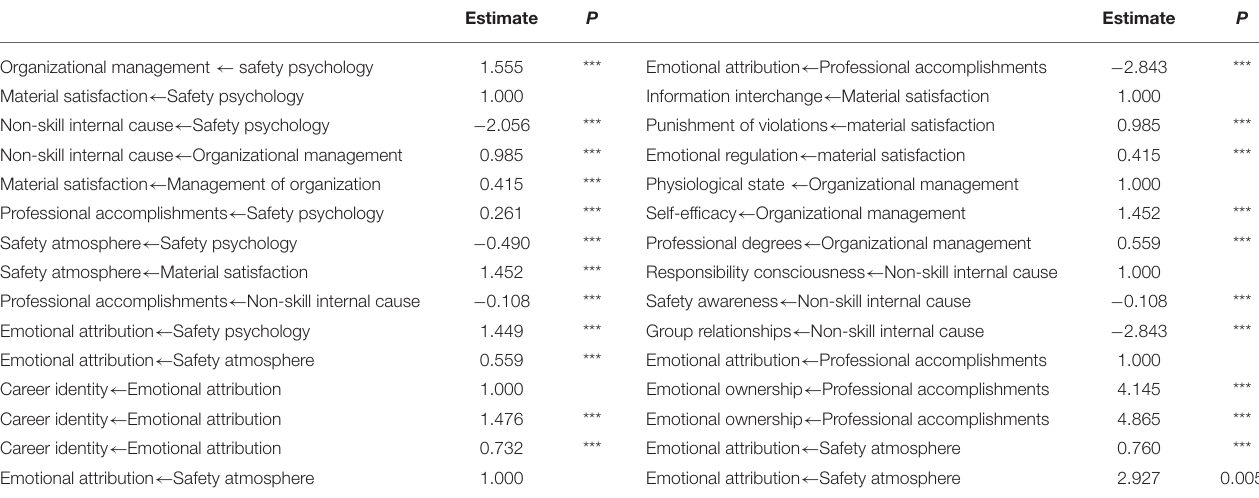
TABLE 12 | Model non-standardized coefficient test